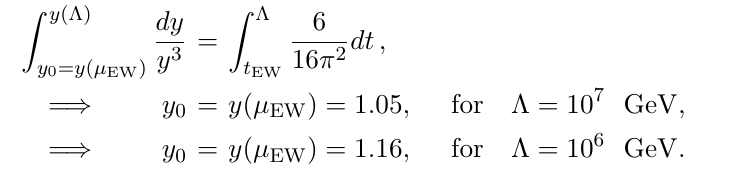
Figure 15 . Perturbative limit on the y coupling at electroweak scale y ( (cid:22) EW ) assuming y ((cid:3)) = as a function of the cut-o(cid:11) scale (cid:3). Green region below the curve is allowed by the limit. The range of (cid:3) has been chosen from that of our analysis to satisfy neutrino mass